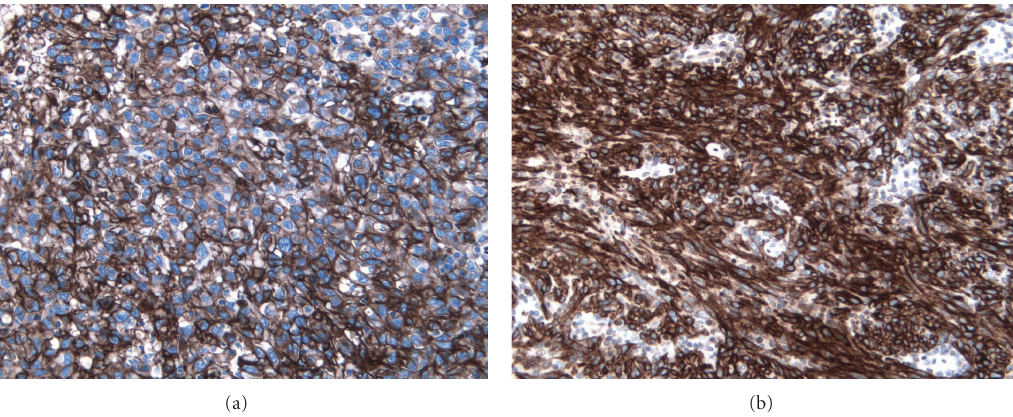
Figure 4: Representative immunohistochemical results for vascular markers. (a) CD31, showing strong and di ff use membranous staining of the endothelial cells. (original magnification × 20). (b) D2-40, showing strong and di ff use membranous staining of the endothelial cells. (original magnification ×